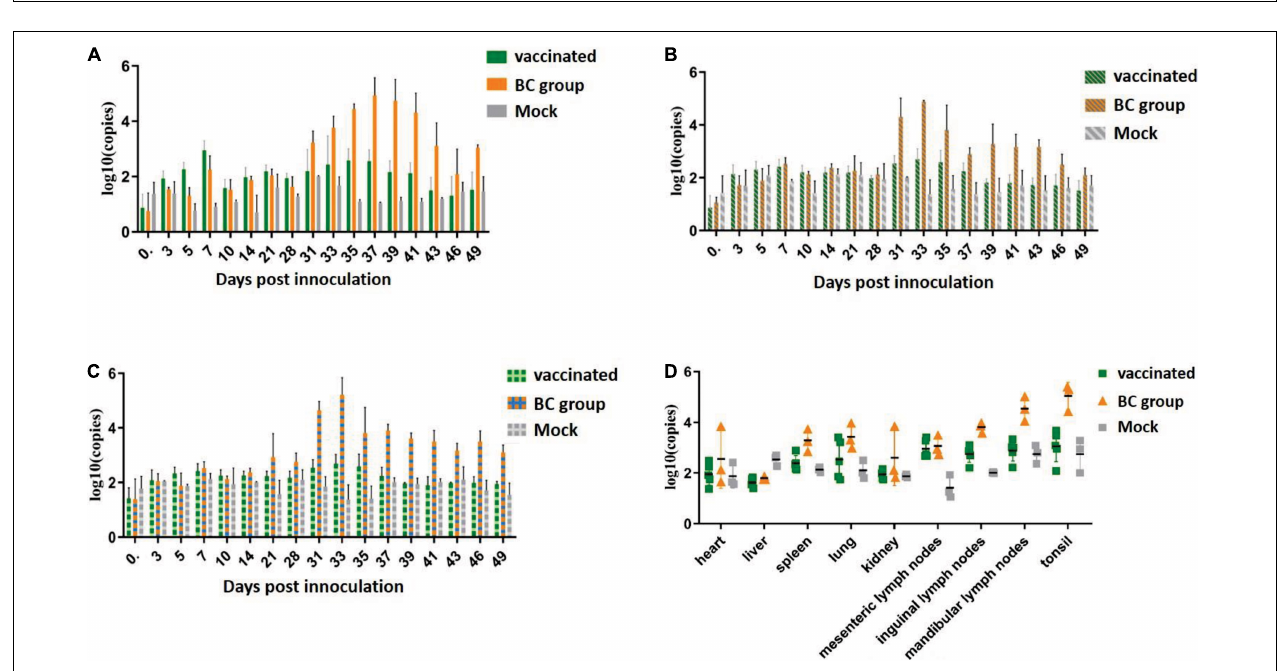
FIGURE 3 | Histopathology analysis by hematoxylin-eosin staining in three groups. Each group’s microscopic figures of the lung, liver, spleen, mesenteric lymph nodes, and mandibular lymph nodes are shown and observed at a magnification of × 200. The infiltration of inflammatory cells around the alveolar septa and alveolar spaces was shown clearly by black arrows.